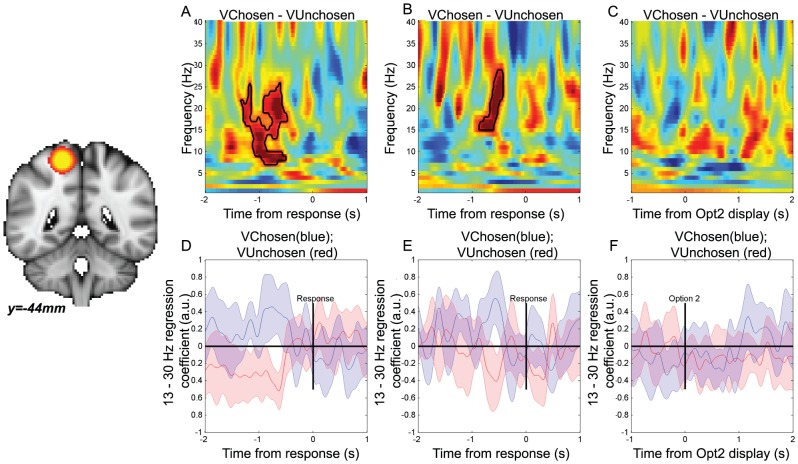
Right posterior superior parietal lobule, identified in our previous study of reward-guided decision making [5], shows beta correlates of chosen-unchosen value on both ‘harder’ and ‘nobrainer’ comparison trials, but not on harder sequential trials.
Parts A–F are equivalent to parts A–F of

figure 6
. (A) Correlates of the value difference between chosen and unchosen options, timelocked to the response, on harder comparison trials. Color represents T-statistic; bordered areas reflect significant clusters (cluster-corrected P<0.05; permutation test). (B) As (A), but for ‘nobrainer’ trials in which probability and magnitude advocated the same response. (C) Correlates of the value difference between chosen and unchosen options, timelocked to option 2 presentation, on harder sequential trials. (D) Separating the pSPL beta band response on harder comparison trials reveals a positive correlate of the value of the chosen option (blue) and a negative correlate of the value of the unchosen option (red) prior to the response. Bars represent mean +/− 95% confidence intervals across subjects. (E) As (D), but for ‘nobrainer’ trials. (F) Separating the beta band response on harder sequential trials reveals no correlate of either chosen or unchosen value in pSPL at the time of option 2 presentation.